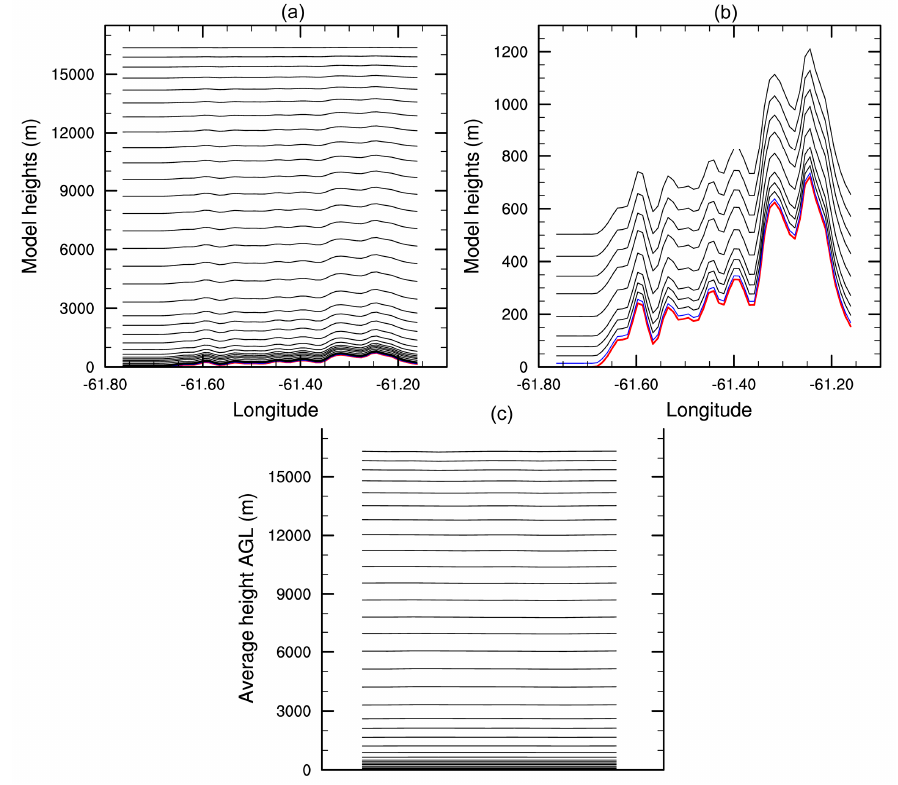
Figure 2. Computational grid in the vertical. ( a ) Profile of all vertical grid levels through a cross-section across 10.72° N along which the highest topographic elevation (712 m) is located; ( b ) The lowest nine vertical grid levels as in ( a ) with the first level indicated in blue and the elevation profile in red; ( c ) The average height of the numerical grid’s vertical levels.